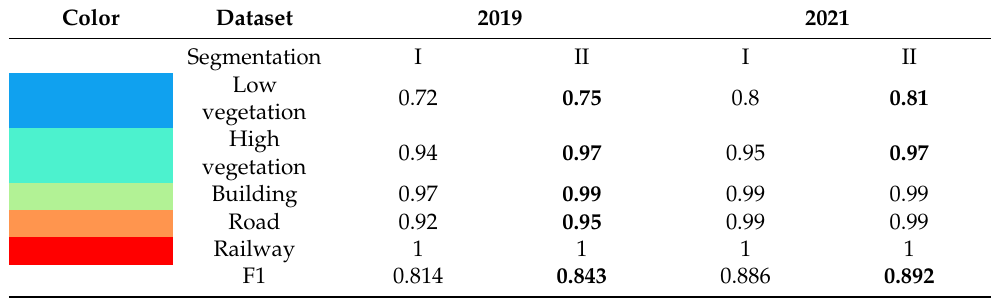
Table 3. Segmentation results with data augmentation for the dataset from 2019 and 2021 for the ResU-Net model based on MCC calculated for each class (the range scales from − 1 to 1) and overall F1 score (the range scales from 0 to 1).